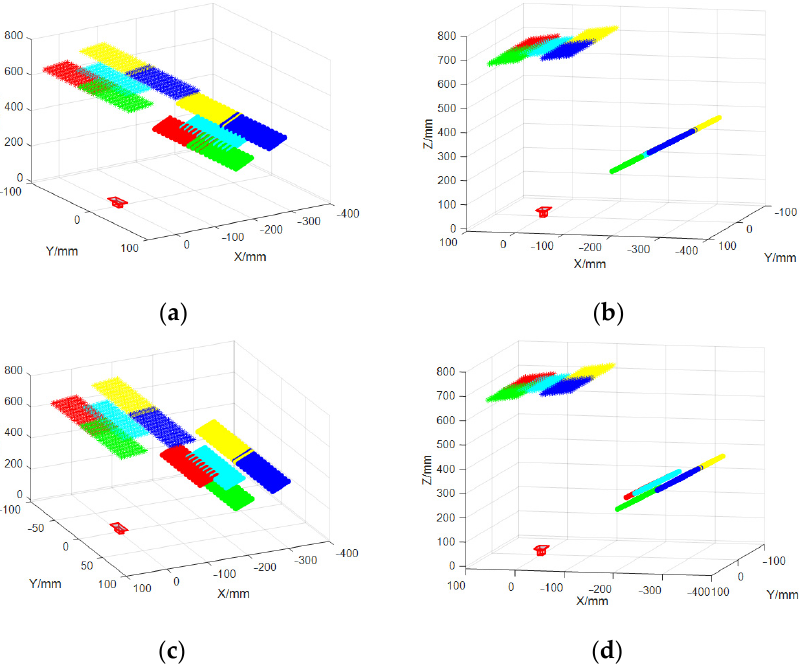
Figure 7. Calibration results with and without coplanar constraints. • points denote the real feature points on the reference plane. ∗ points denote the mirrored feature points. ( a ) Calibration results with coplanar constraints in view 1. ( b ) Calibration results with coplanar constraints in view 2. ( c ) Calibration results without coplanar constraints in view 1. ( d ) Calibration results without coplanar constraints in view 2. Yellow: Grid location 1-STZ. Blue: Grid location 2-STZ. Green: Grid location 3-STZ. Red: Grid location 4-STZ. Cyan: Grid location 5-STZ.